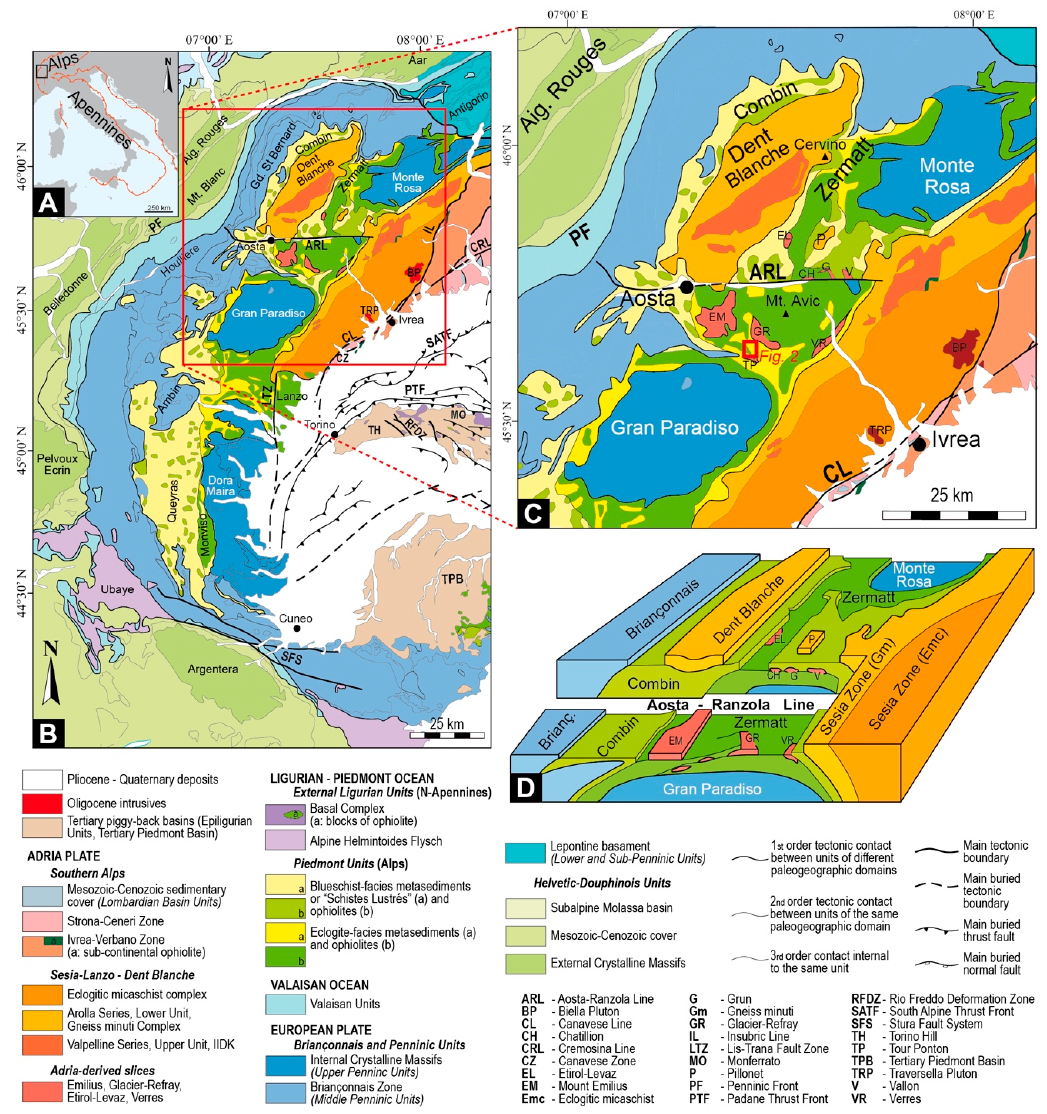
Figure 1. Geographic and geological location of the study area. ( A ) Location of the W Alps and the study area (square) in the Italian peninsula. ( B ) Tectonic map of the W Alpine belt illustrating the distribution of the tectonic domains involved in the Alpine orogeny (see text). Red square outlines the area zoomed in Figure 1C. ( C ) Tectonic map of the Aosta valley and surrounding areas, with location of the study area (mapped in Figure 2) and of the Mount Avic serpentinite massif (M. Avic). ( D ) 3D-block diagram across the Aosta-Ranzola fault system (Aosta-Ranzola Line) trending parallel to the central Aosta valley. Figures 1A–C: modified after [59]. Figure 1D: redrawn after [33].